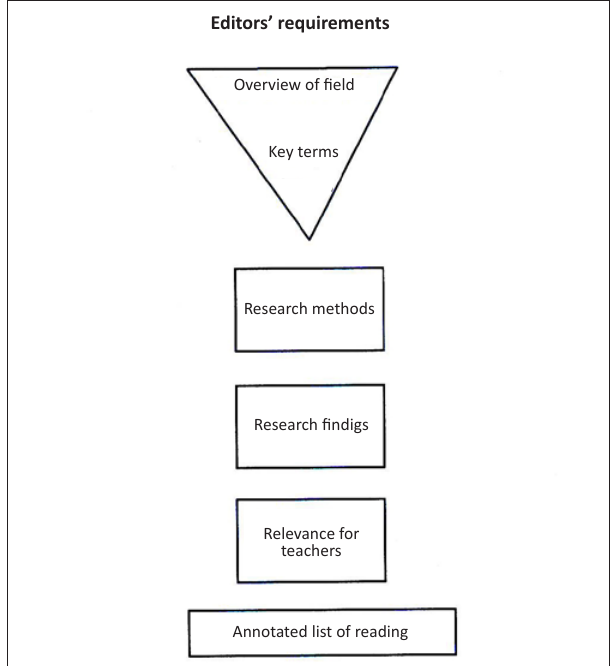
FIGURE 5: The editor’ structural requirements for the article.